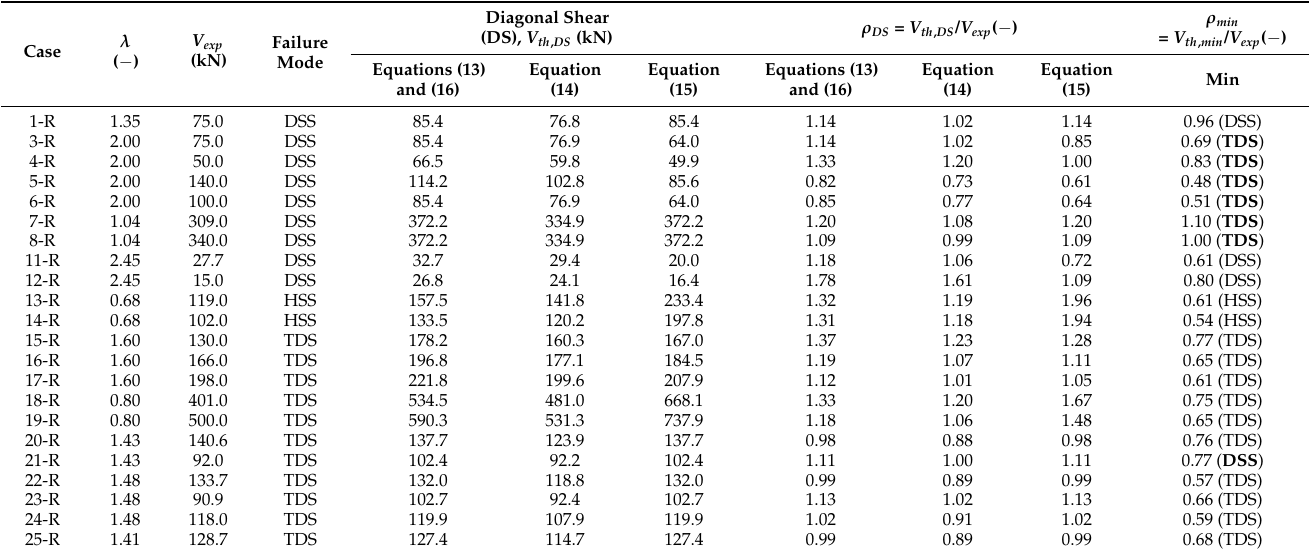
Table 10. Comparison between experimental and theoretical capacities.